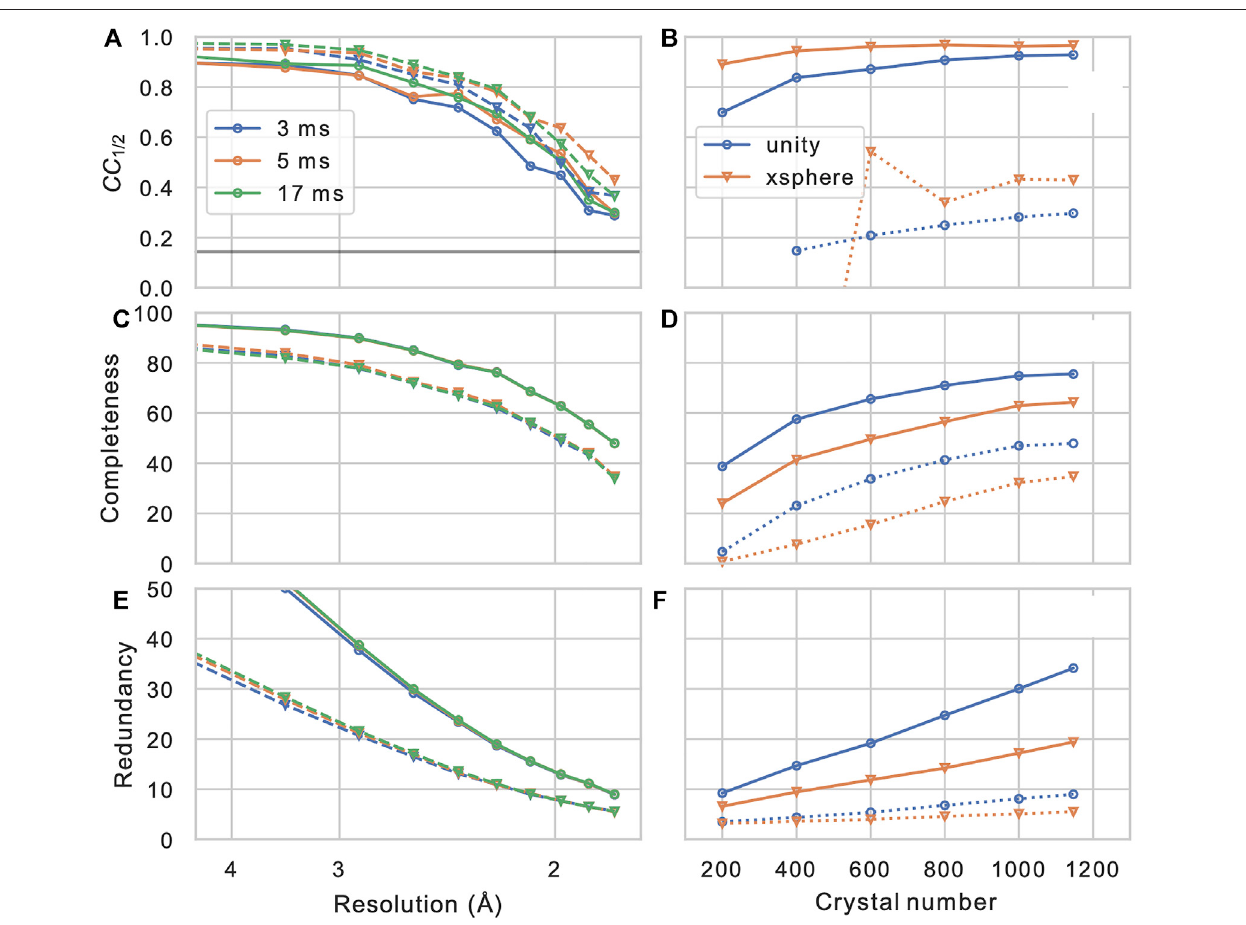
FIGURE 7 | Merging statistics as a function of resolution (A – C) and crystal number (D – F) : Half-set Pearson correlation CC 1/2 , dataset completeness, and observation redundancy. In (A – C) , results are shown for three different integration times in different colors, and for merging without (solid lines, circles) or with (dashed lines, triangles) the xsphere partiality model (White, 2014). In (D – F) , solid and dashed lines represent values from the entire resolution range and from the highest resolutionshell(centeredat1.83 Å),respectively.Bluecirclesandorangetrianglesrepresentresultsfrommergingwithoutandwithpartialitymodeling,respectively, iterative scaling was enabled in both